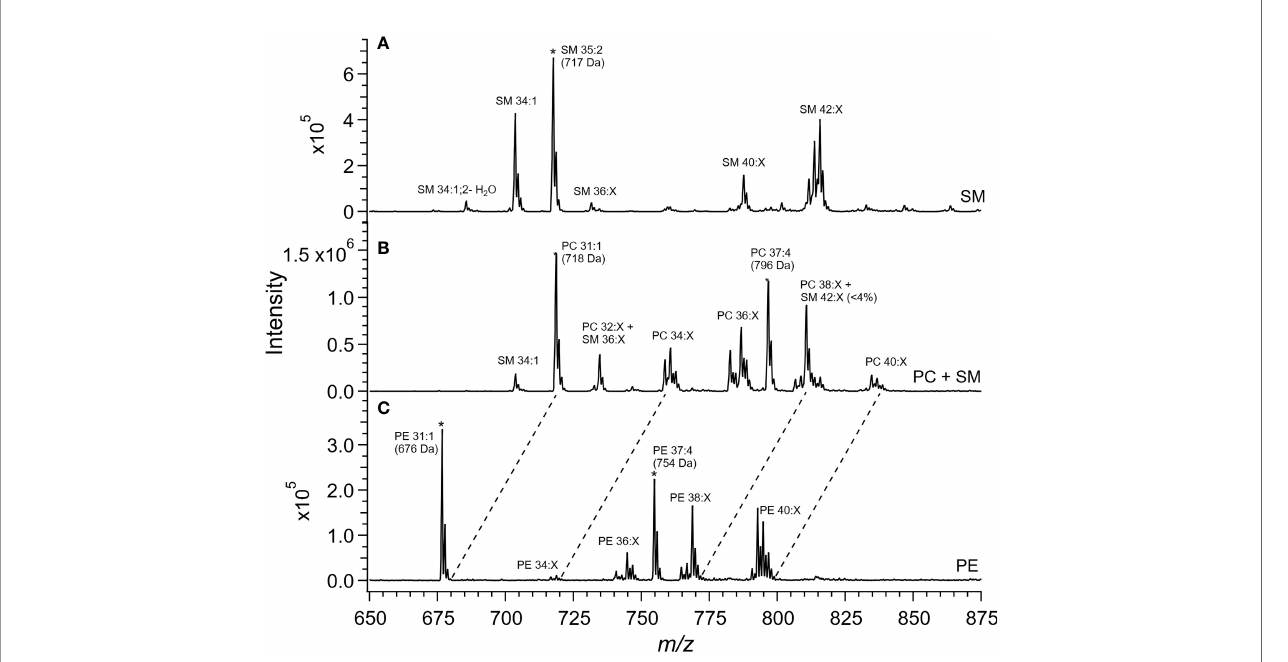
FIGURE 1 | Mass spectra of placental extracts from NF-WT mouse. Selective scans for (A) sphingomyelin (SM) using the product ion m/z 184 with differential ion mobility, (B) phosphatidylcholine and sphingomyelin using product ion m/z 184, and (C) phosphatidylethanolamine using the neutral loss of 141 Da. Internal standards are indicated with *. Dashed lines indicate glycerophospholipid groups with common acyl carbon